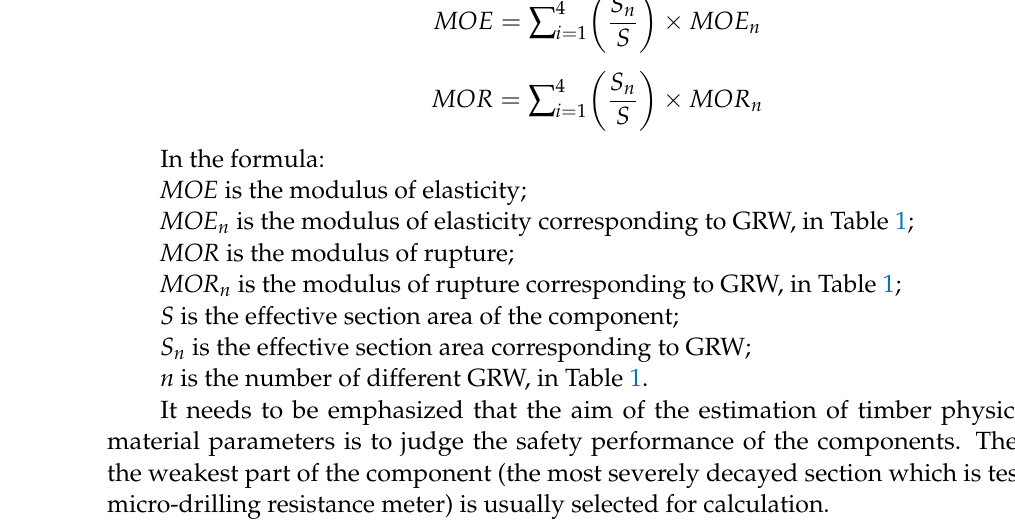
Figure 8. The method to divide different GRW areas in the components; ( a ) multiple direction judgment atlas; ( b ) partition area.